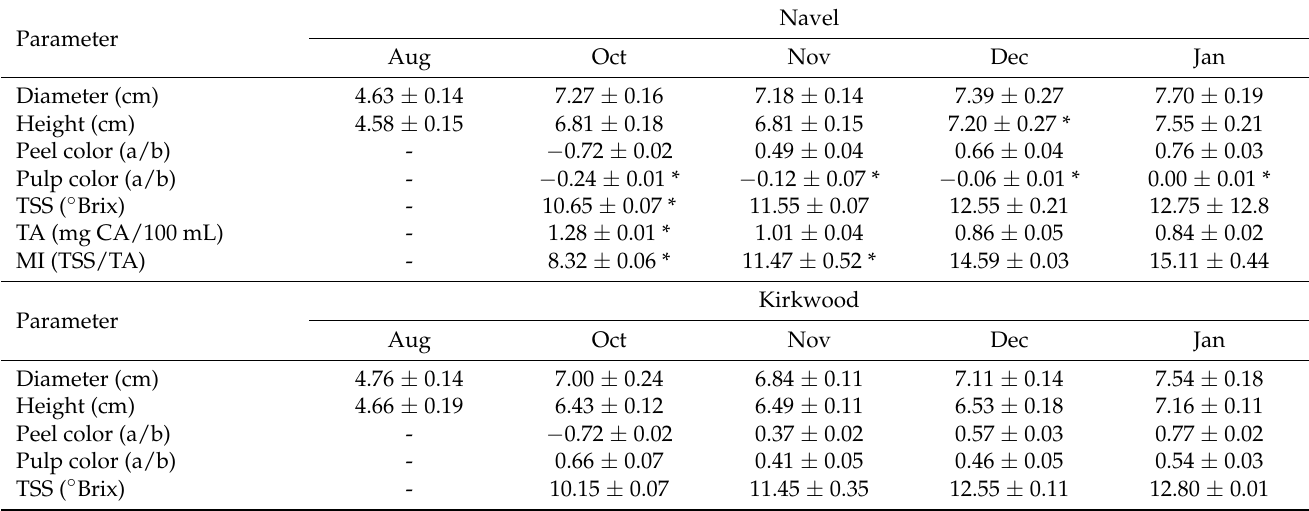
Table 1. Changes in fruit diameter and height, peel and pulp color and internal quality parameters of Navel and the red-fleshed Kirkwood oranges during development and